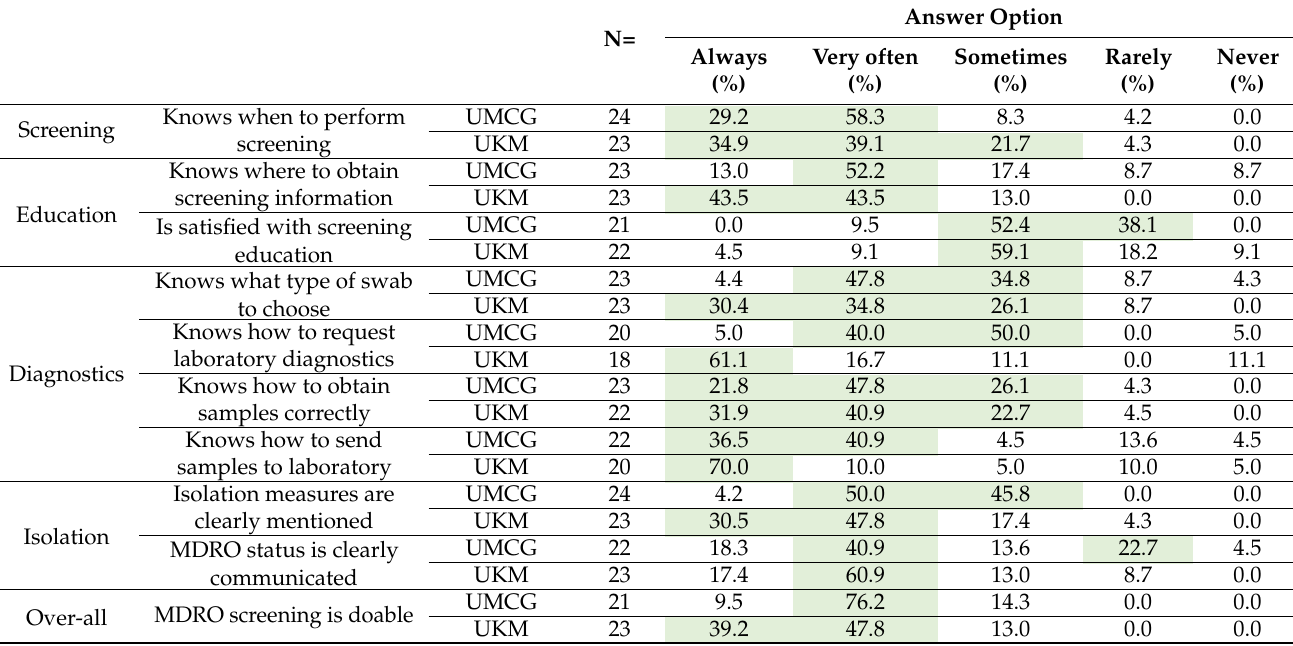
Table 4. Survey responses of healthcare professionals for MDRO screening.